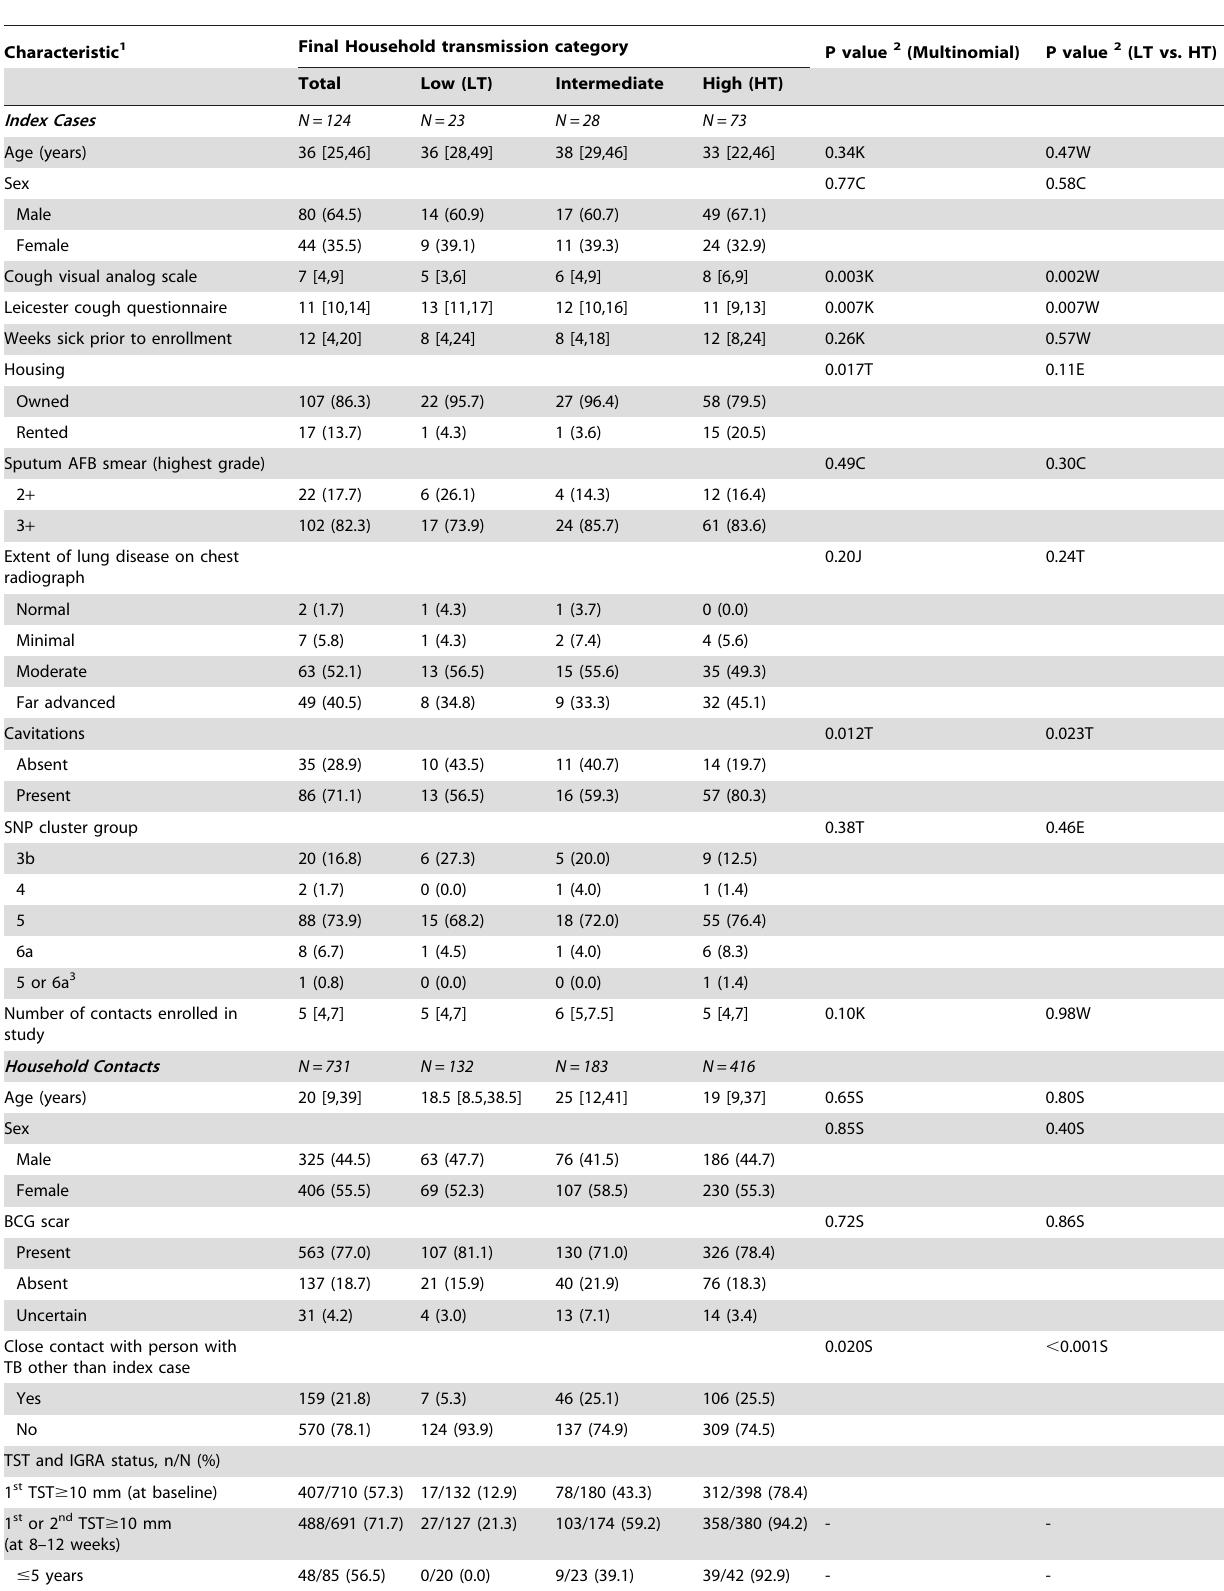
Table 1. Characteristics of index tuberculosis cases, household contacts and study dwellings at baseline by Mycobacterium tuberculosis transmission